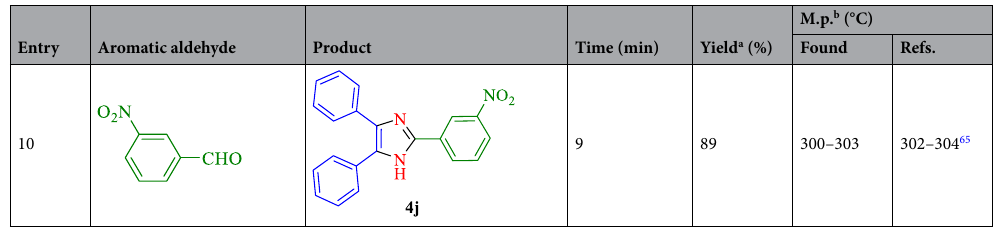
Table 5. Cr 2 O 3 catalyzed the synthesis of imidazole derivatives 4a–j . a Isolated yields. b The measured melting points comparison with those in literature confirmed the products.